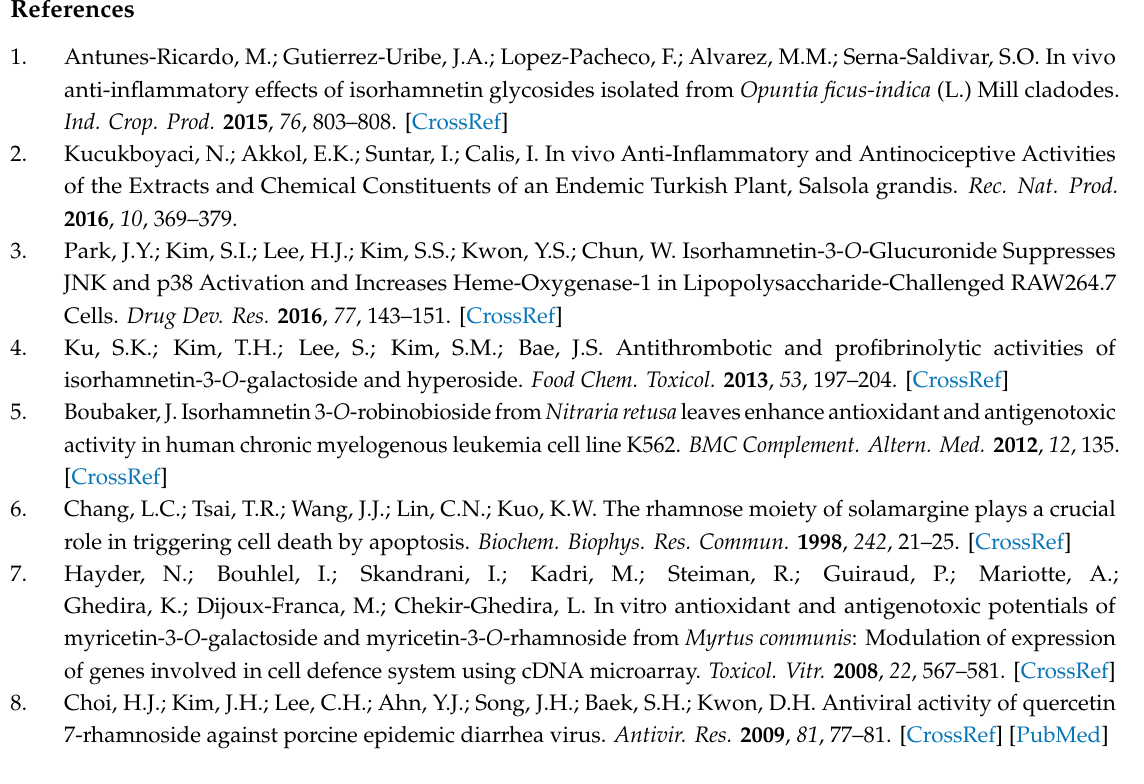
Figure S2: The structural